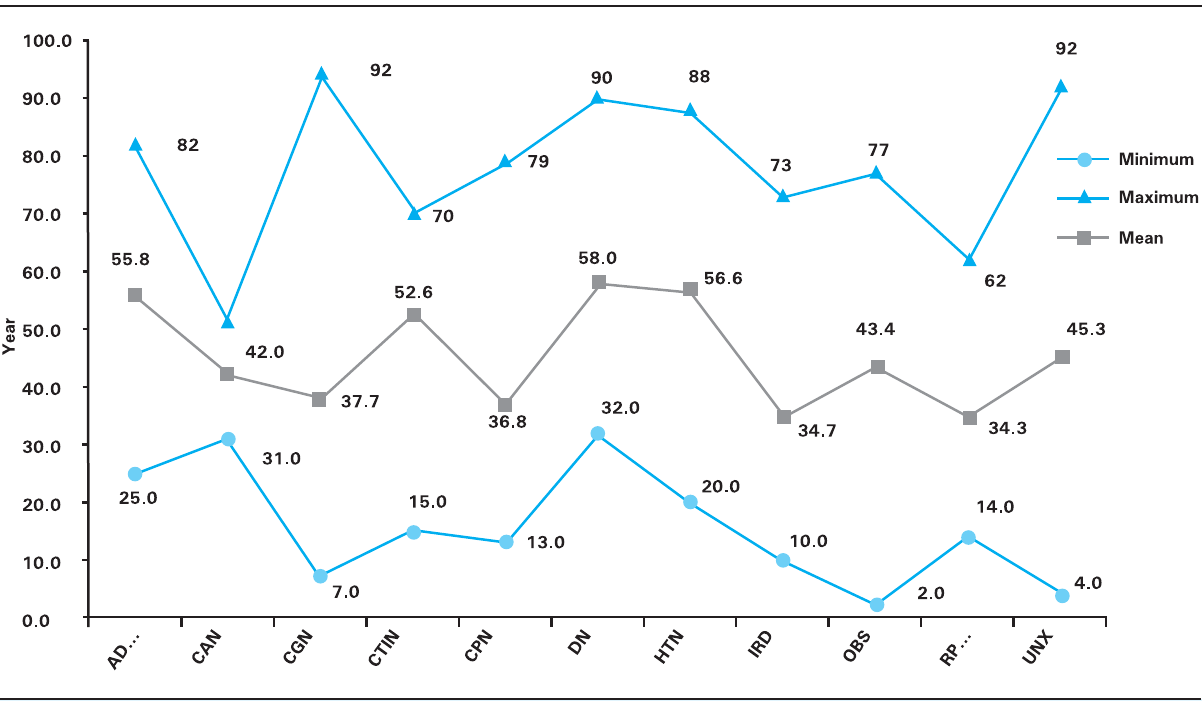
Figure 1. Mean age (years) of patients with different